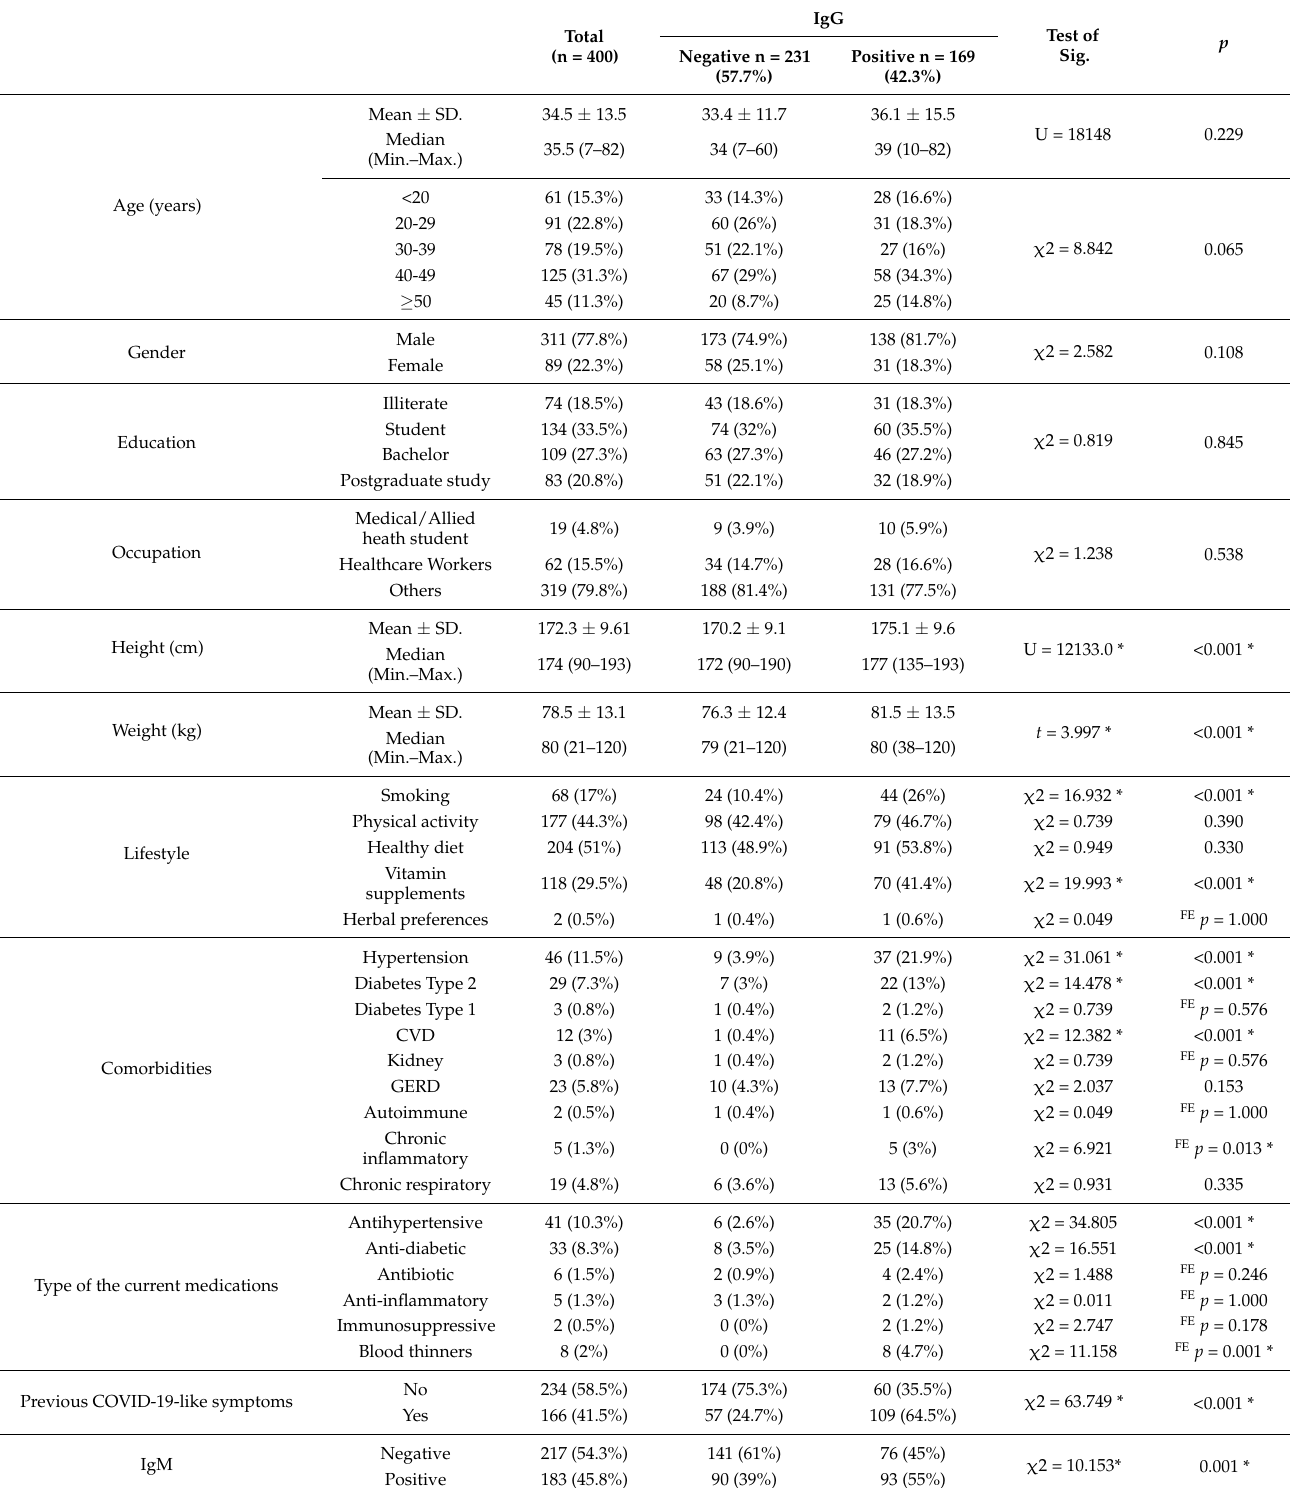
Table 3. Comparison of the history, demographics, anthropometrics, and lifestyle of the participants stratified for the extent of anti-SARS-CoV-2 IgG in their blood (Total n = 400). Data shown are frequencies; n. (%), and mean ± SD (median; range). IgG Test of Total p Sig. Negative n = 231 Positive n = 169 (n = 400) (57.7%)